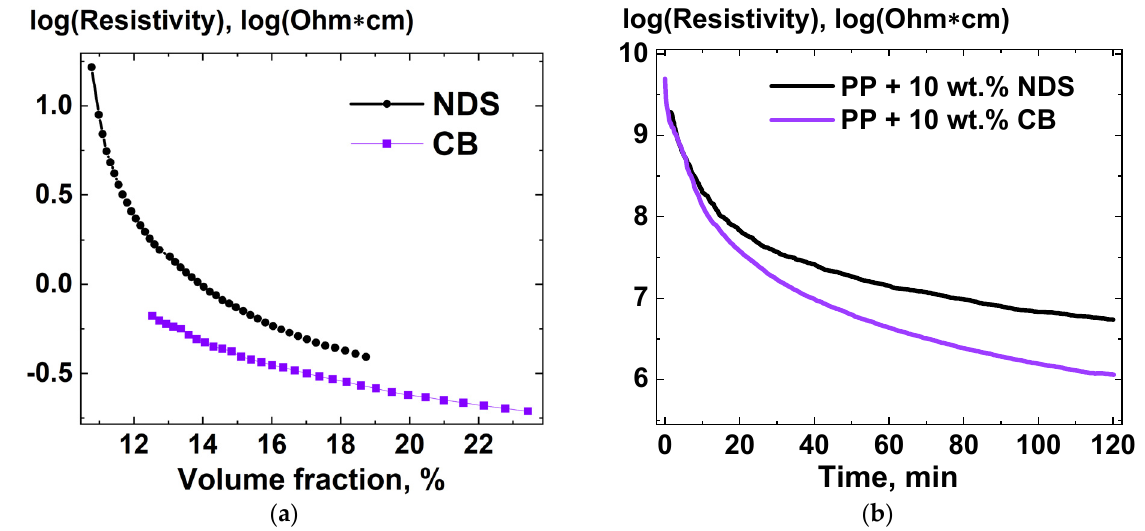
Figure 6. ( a )—Resistivity of NDS and CB powders versus volume fraction of the powder particles in a cylindric tube, measured between two steel pistons acting as electrodes; ( b )—resistivity of melts of the composites PP + 10 wt.% NDS and PP + 10 wt.% CB [21], measured between two aluminum electrodes located at the bottom and top of a closed cylindric mold (radius—1.5 cm, height—0.2 cm) at temperature of 205 °C, versus time.